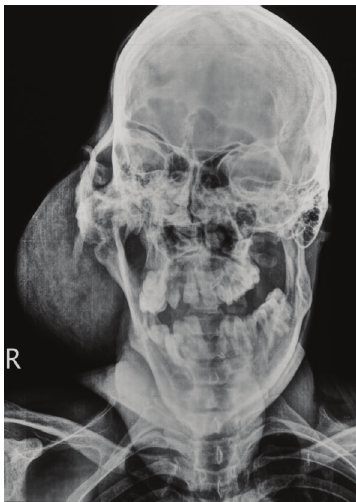
Figure 7: Posteroanterior view of the skull showing appreciable generalized bony and soft tissue enlargement of the right face.